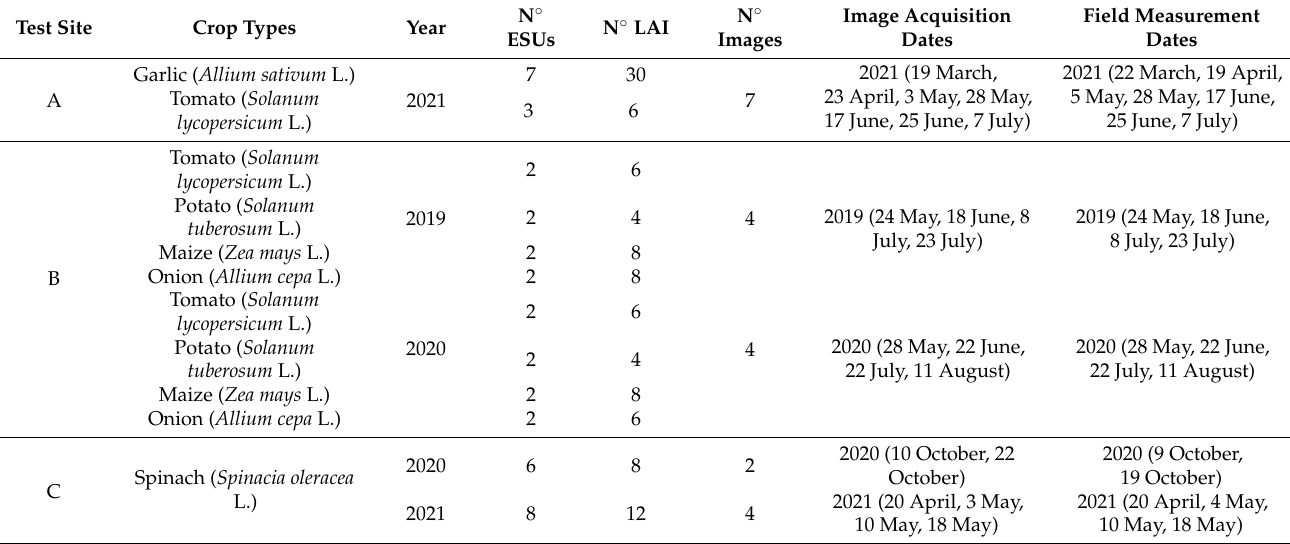
Table 1. Characteristics of the three datasets used in this study.